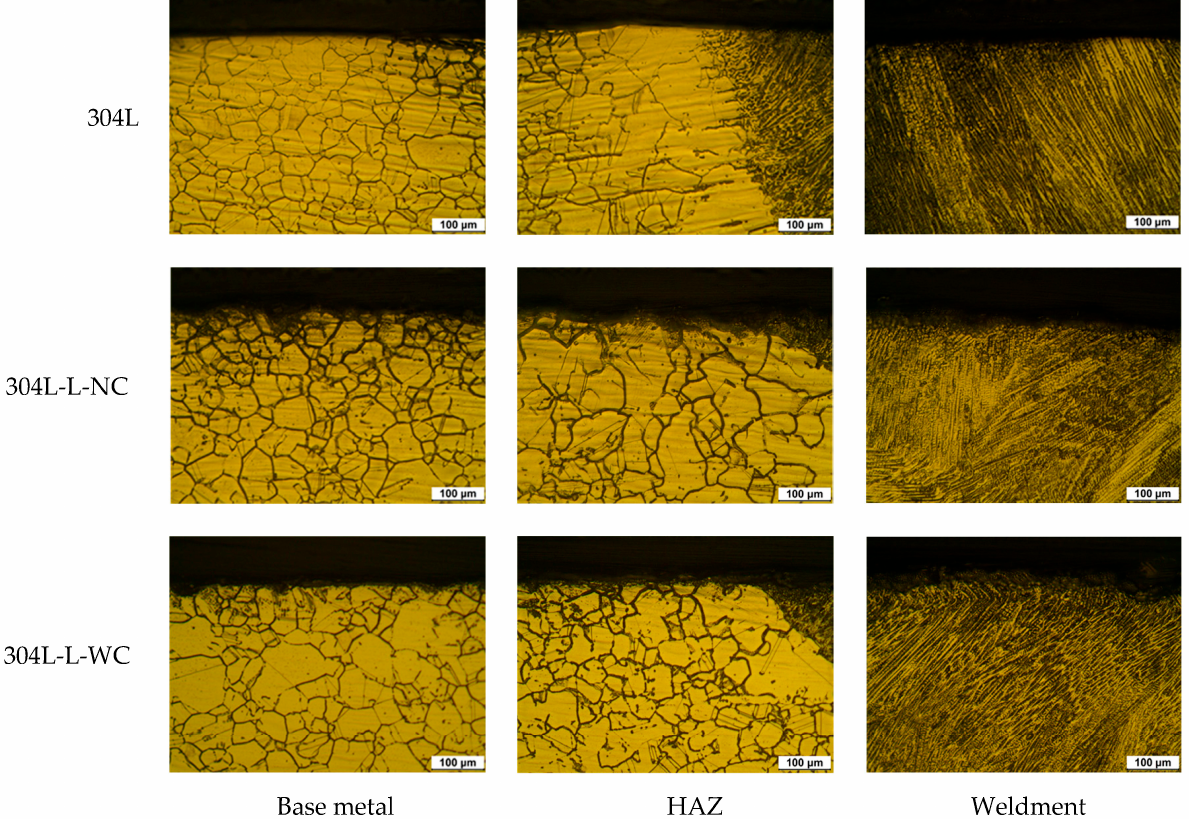
Figure 2. Effect of laser peening on the degree of sensitization obtained by ASTM A262 Pr. A for the outermost area of the cross-section of 304L stainless steel (OM, ×200).